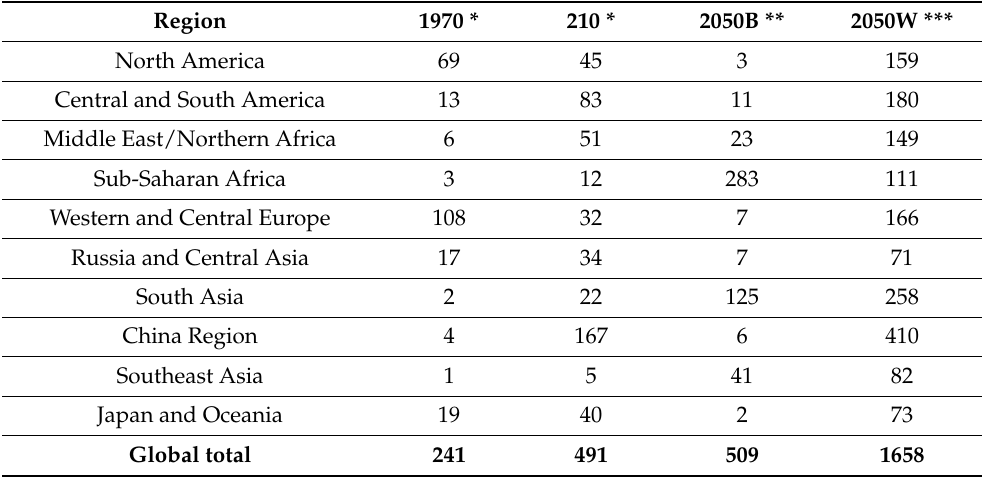
Table 3. Global and regional trends and projections for total emission of phosphorus by laundry detergents (106 kg P/year) (adapted from Van Puijenbroek et al. [32]). Region 1970 * 210 * 2050B ** 2050W *** North America 159 Central and South America Middle East/Northern Africa Sub-Saharan Africa Russia and Central